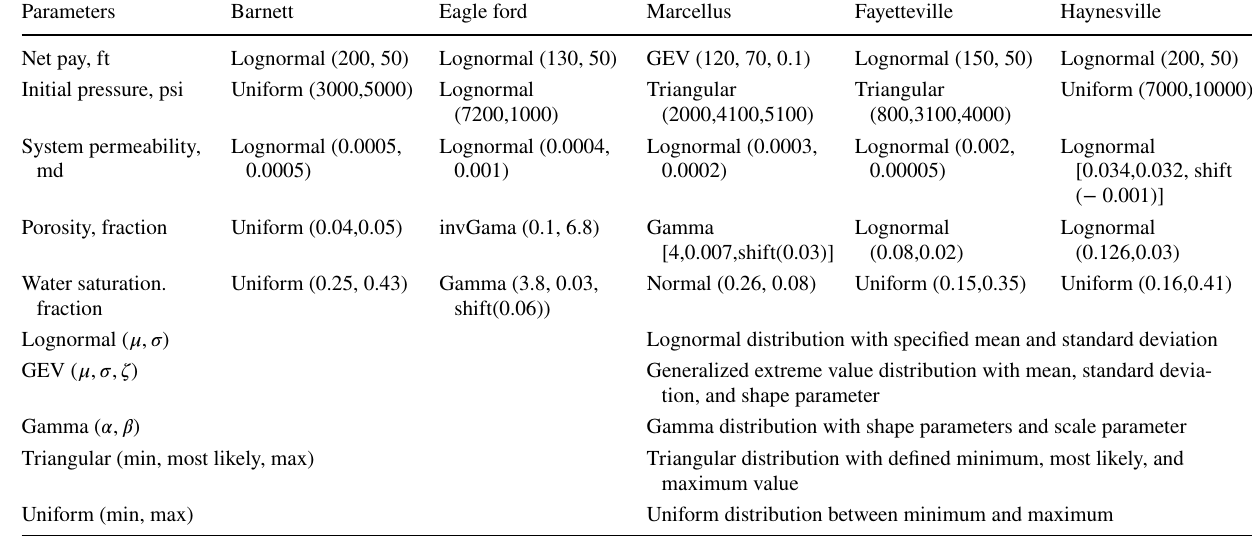
Table 5 Uncertainty parameters’ distribution